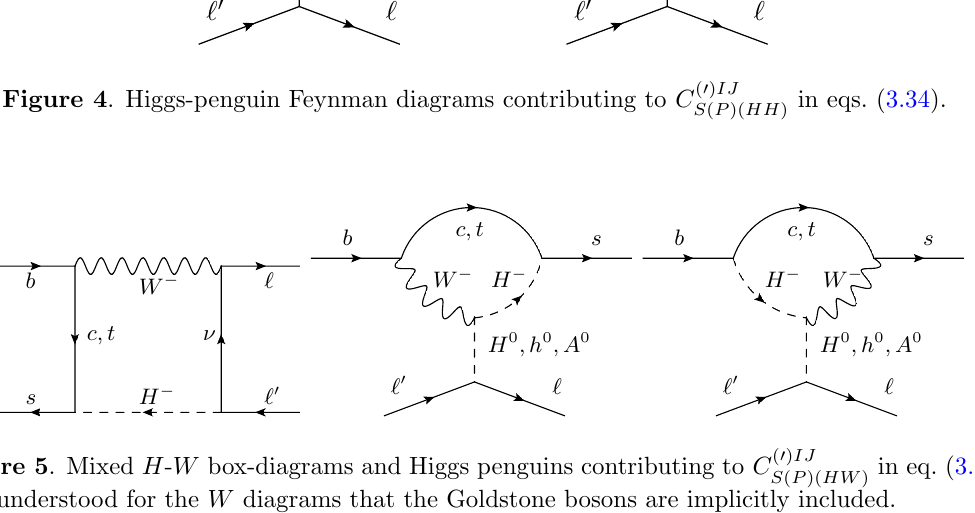
Figure 4 . Higgs-penguin Feynman diagrams contributing to C ( 0 ) IJ